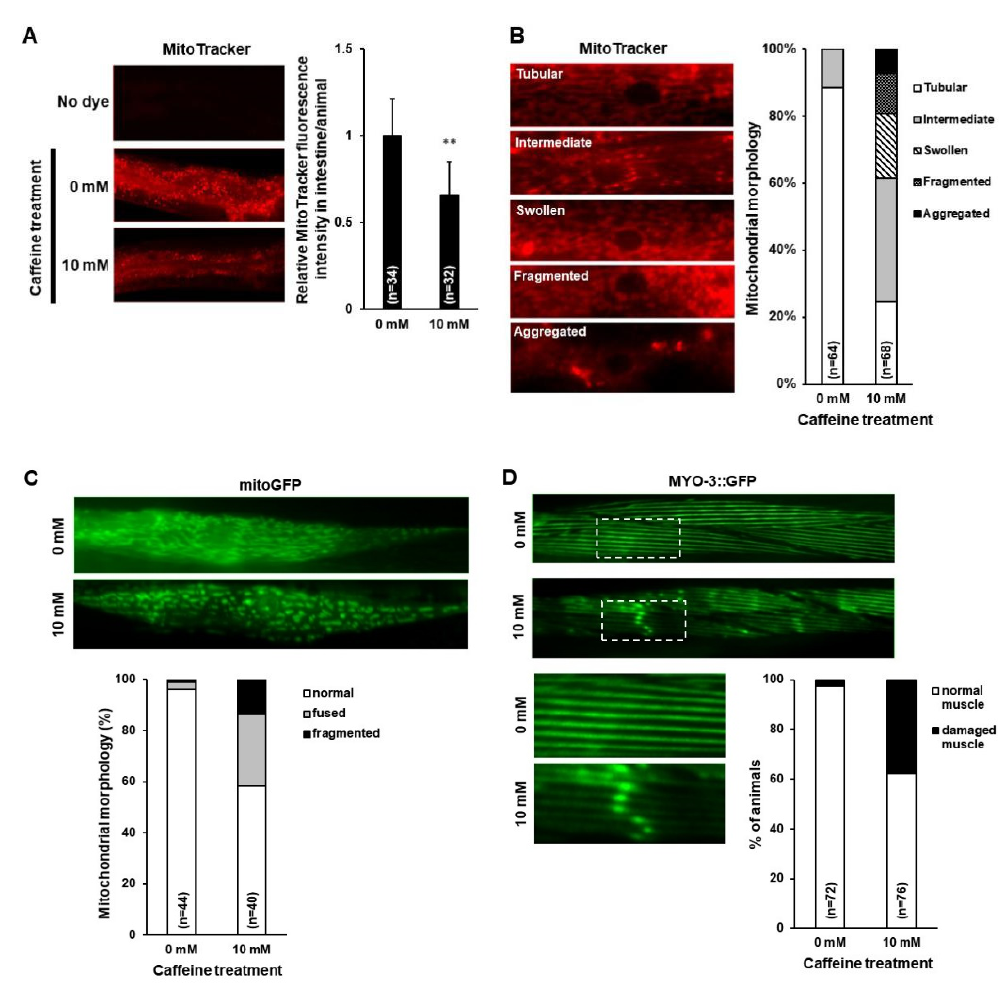
Figure 2. Caffeine intake reduced mitochondrial activity and disrupted mitochondrial morphology in Caenorhabditis elegans . ( A ) Comparison of mitochondrial activity in the intestine of caffeine-fed animals (10 mM) and that of the caffeine-free diet control group (0 mM) using MitoTracker staining. The graph shows the relative level of mitochondrial activity using ImageJ analysis. Statistical significance was calculated using Student’s t -test. **, p < 0.01. Error bars represent standard deviation. ( B ) Comparison of mitochondrial morphology in the muscle cells of caffeine-fed animals (10 mM) and that of the caffeine-free diet control group (0 mM) using MitoTracker staining. The graph indicates the percentage of animals with mitochondria classified as tubular, intermediate, fragmented, swollen, or aggregated. ( C ) The effect of caffeine intake on mitochondrial morphology was analyzed in the transgenic animal SJ4103 expressing a mitochondrial-targeted GFP under control of the muscle-specific myo-3 promoter. The graph indicates the percentage of animals with muscle mitochondria classified as indicated. ( D ) Myofilament abnormality owing to caffeine intake was visualized using the MYO-3::GFP transgene. Representative fluorescent images in the caffeine-free diet control group (0 mM) showed normal filament organization. MYO-3::GFP abnormalities (aggregations) were observed in the caffeine-fed animals (10 mM). The graph indicates the percentage of animals classified as having normal muscle or damaged muscle (aggregations).